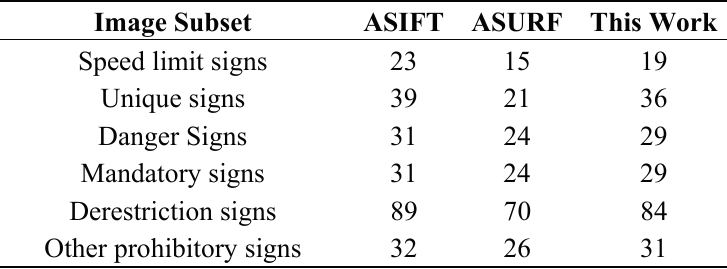
Table 5. Correctly matched points